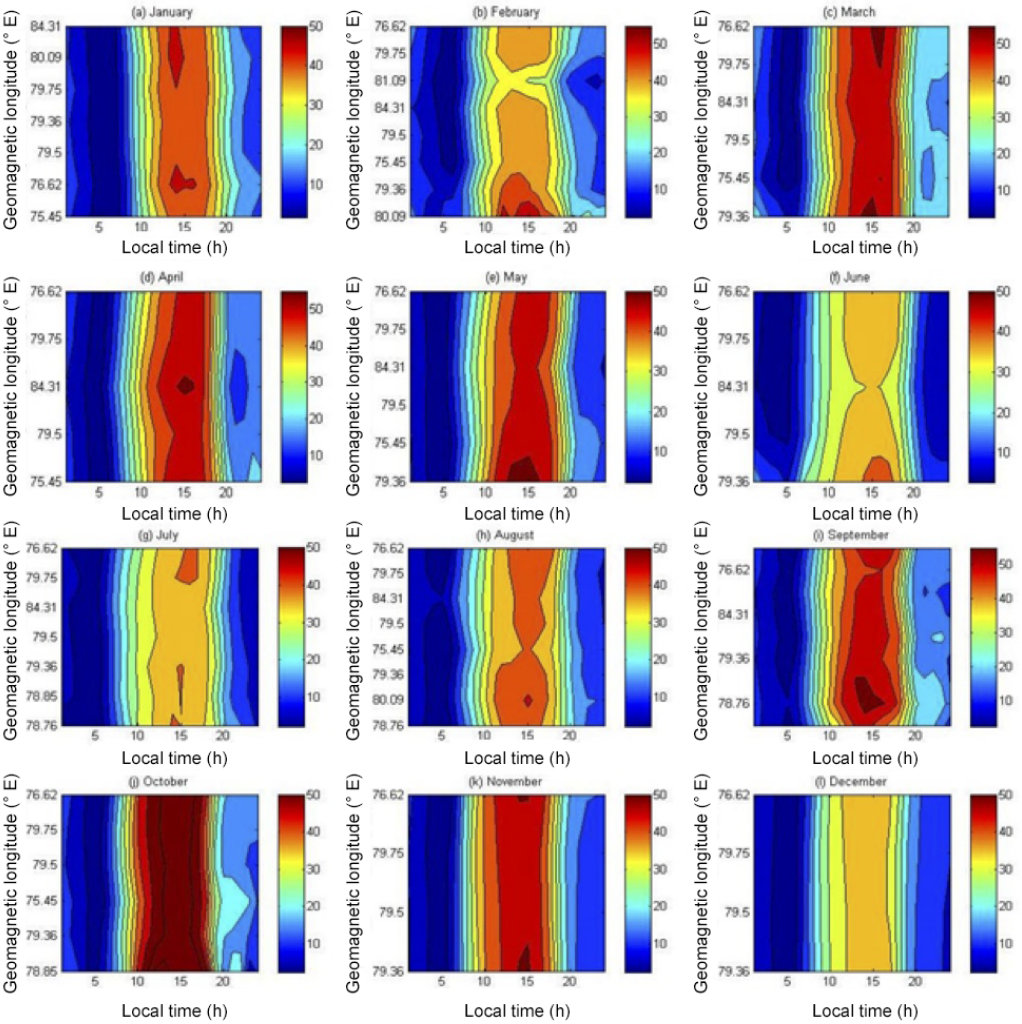
Figure 4. Hourly variation in GPS TEC in all the months along longitude. Data from all stations were used in this figure, except RSUT, CLBR, and FPNO, which were not used to derive maps for the months of March Equinox. Also, RSUT and FPNO were not used to derive maps for the months of December Solstice due to poor data